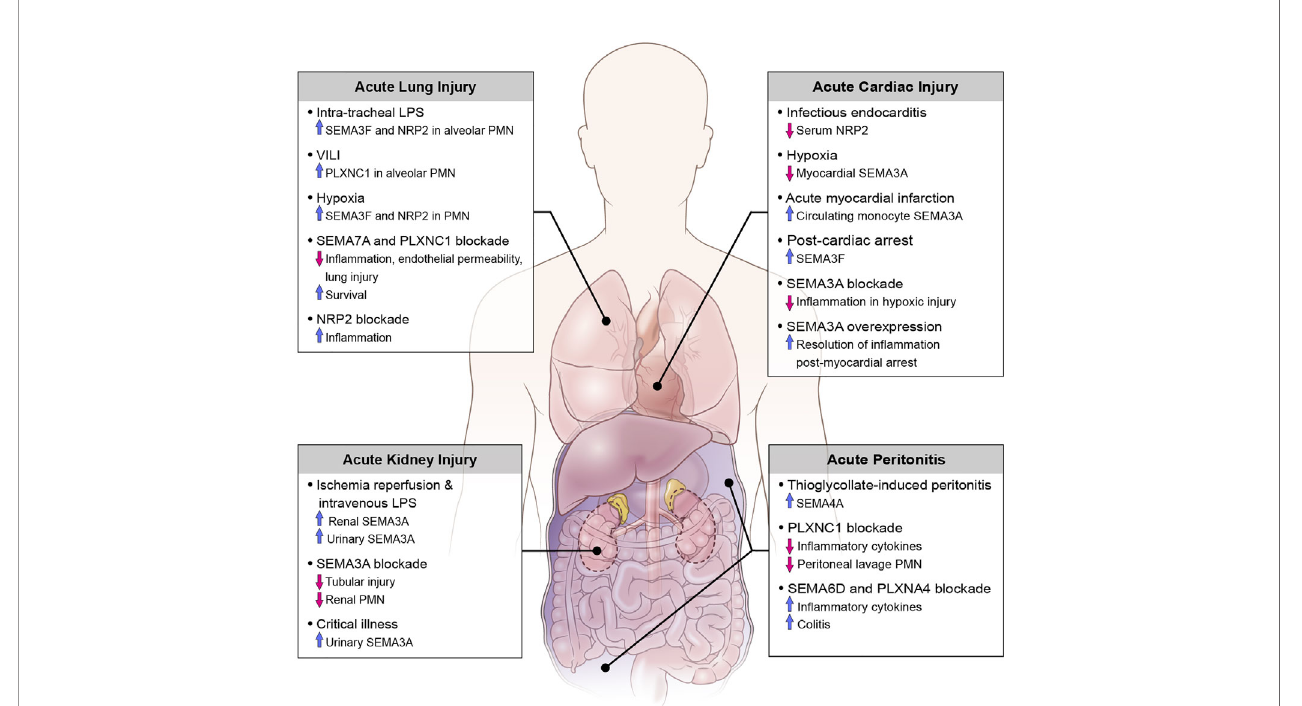
FIGURE 2 | Role of semaphorins and their receptors in clinical conditions of acute in fl